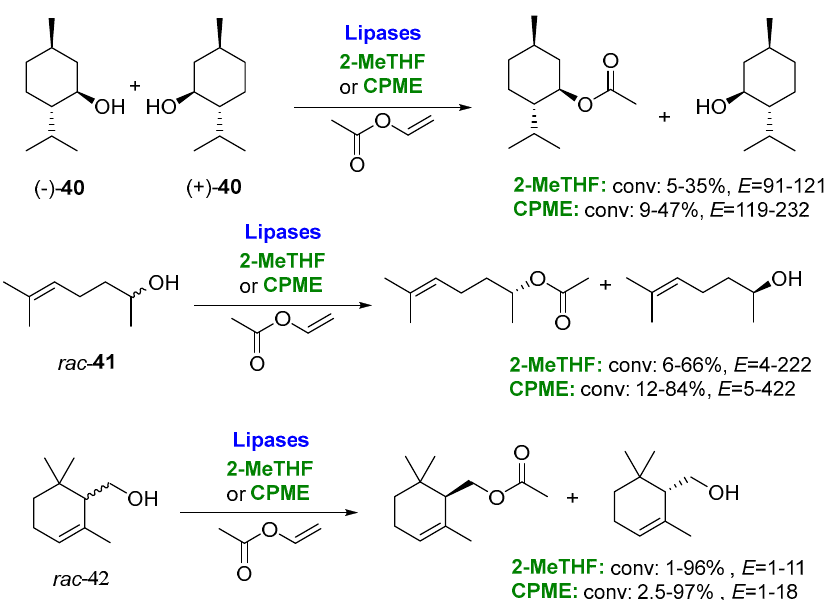
Figure 21. Kinetic resolution of racemic alcohols via lipase-catalyzed acylation with vinyl acetate in 2-MeTHF and CPME.